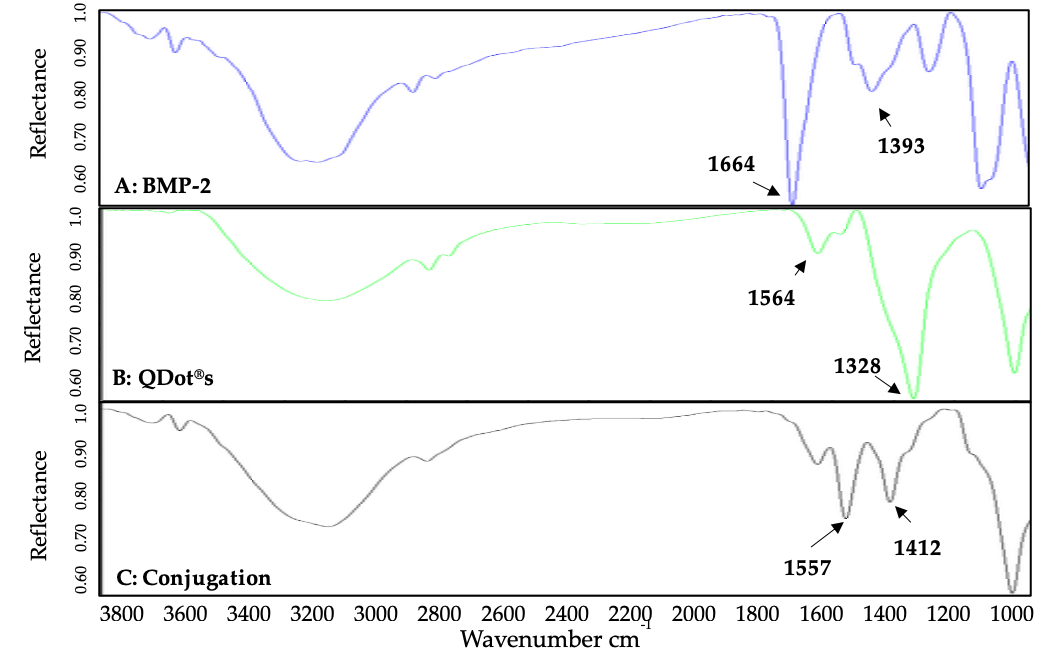
Figure 2. FTIR spectrometer readings of BMP-2 ( A ), QDot ® s ( B ), and BMP-2-QDot ® ( C ) samples drop-casted onto gold-coated coverslips. Samples were collected using Bruker Optics and a Hyperion 2000 microscope with a Mercury Cadmium Telluride (MCT) detector with 64 scans at a resolution of 4 cm − 1 . Experiments were repeated at least three times.